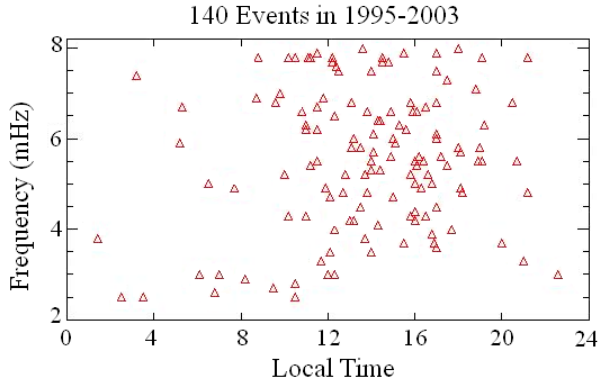
Fig. 2. Distribution in frequency (2 to 8mHz) and local time of the narrow-band Pc5 pulsation events from GOES-8 geosynchronous measurements in the period from 1995 to